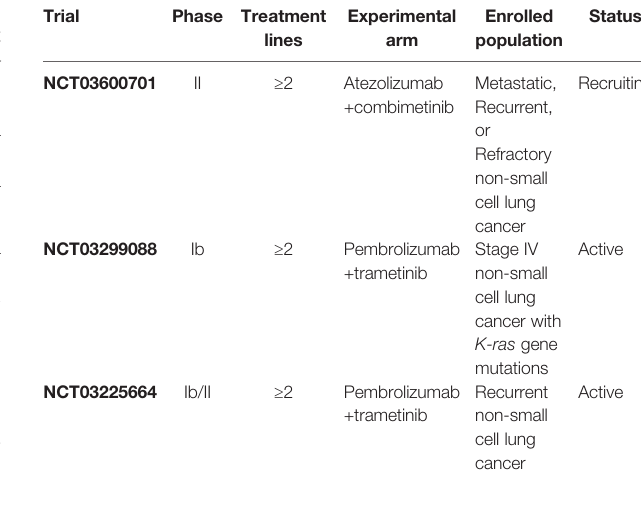
TABLE 3 | Several ongoing trials of ICIs combined with targeted